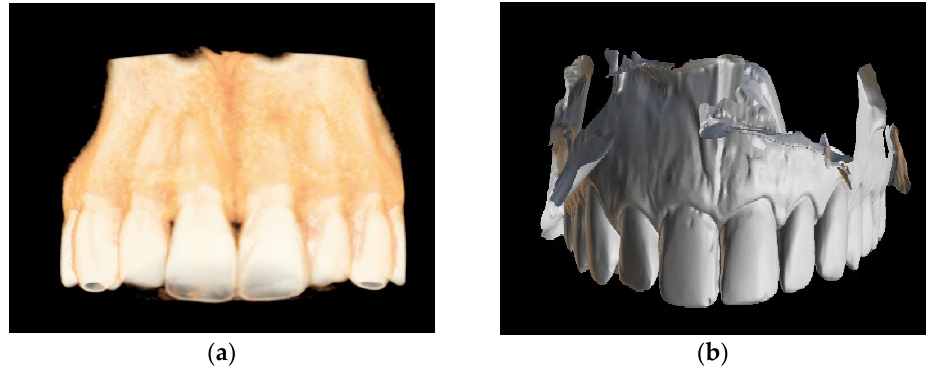
Figure 1. ( a ) Cone-beam computed tomography (CBCT) image presenting patient’s maxilla; ( b ) patient’s intraoral scan of upper arch.